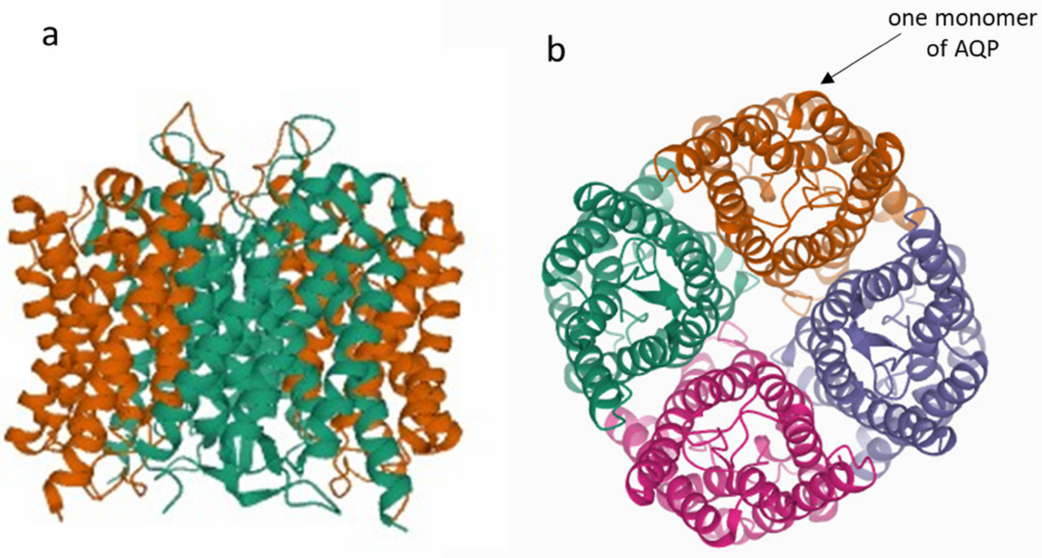
Figure 2. The structure of aquaporin represented by the crystal structure of Arabidopsis AtPIP2;4 (PDB 6QIM) [20]. The view from different sides of the holoprotein shows that it consists of monomers. ( a ) A side view of an asymmetric unit. ( b ) Tetrameric assembly from the cytoplasmic